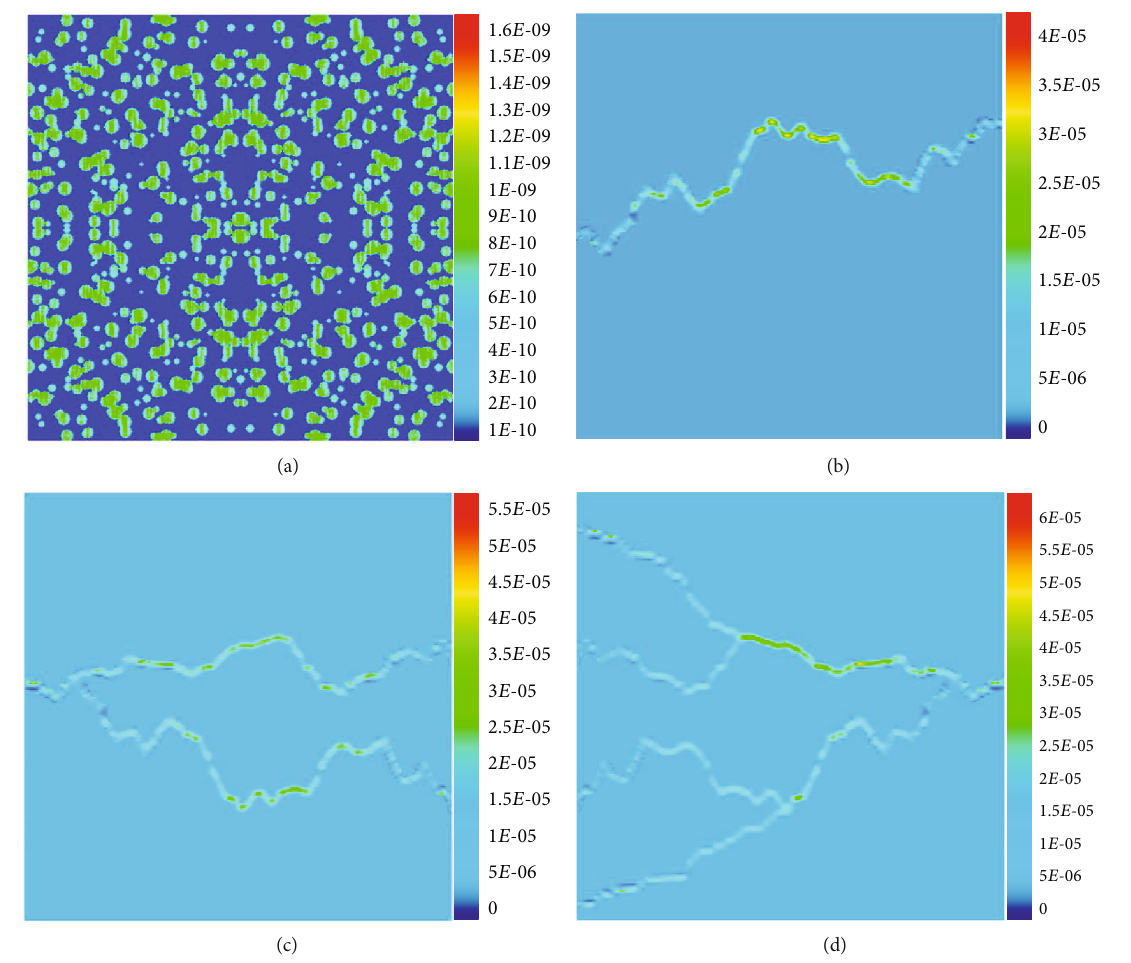
Figure 7: Velocity distribution in di ff erent fracture